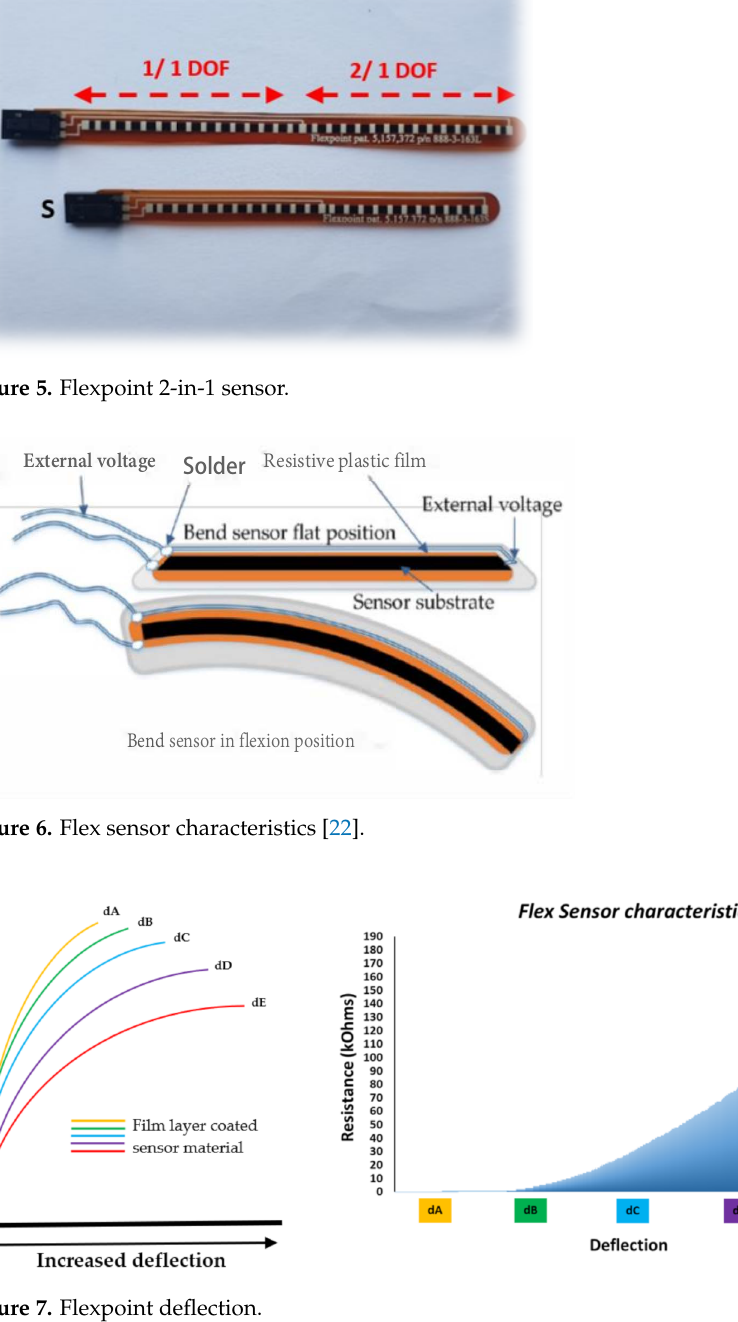
Figure 7. Flexpoint